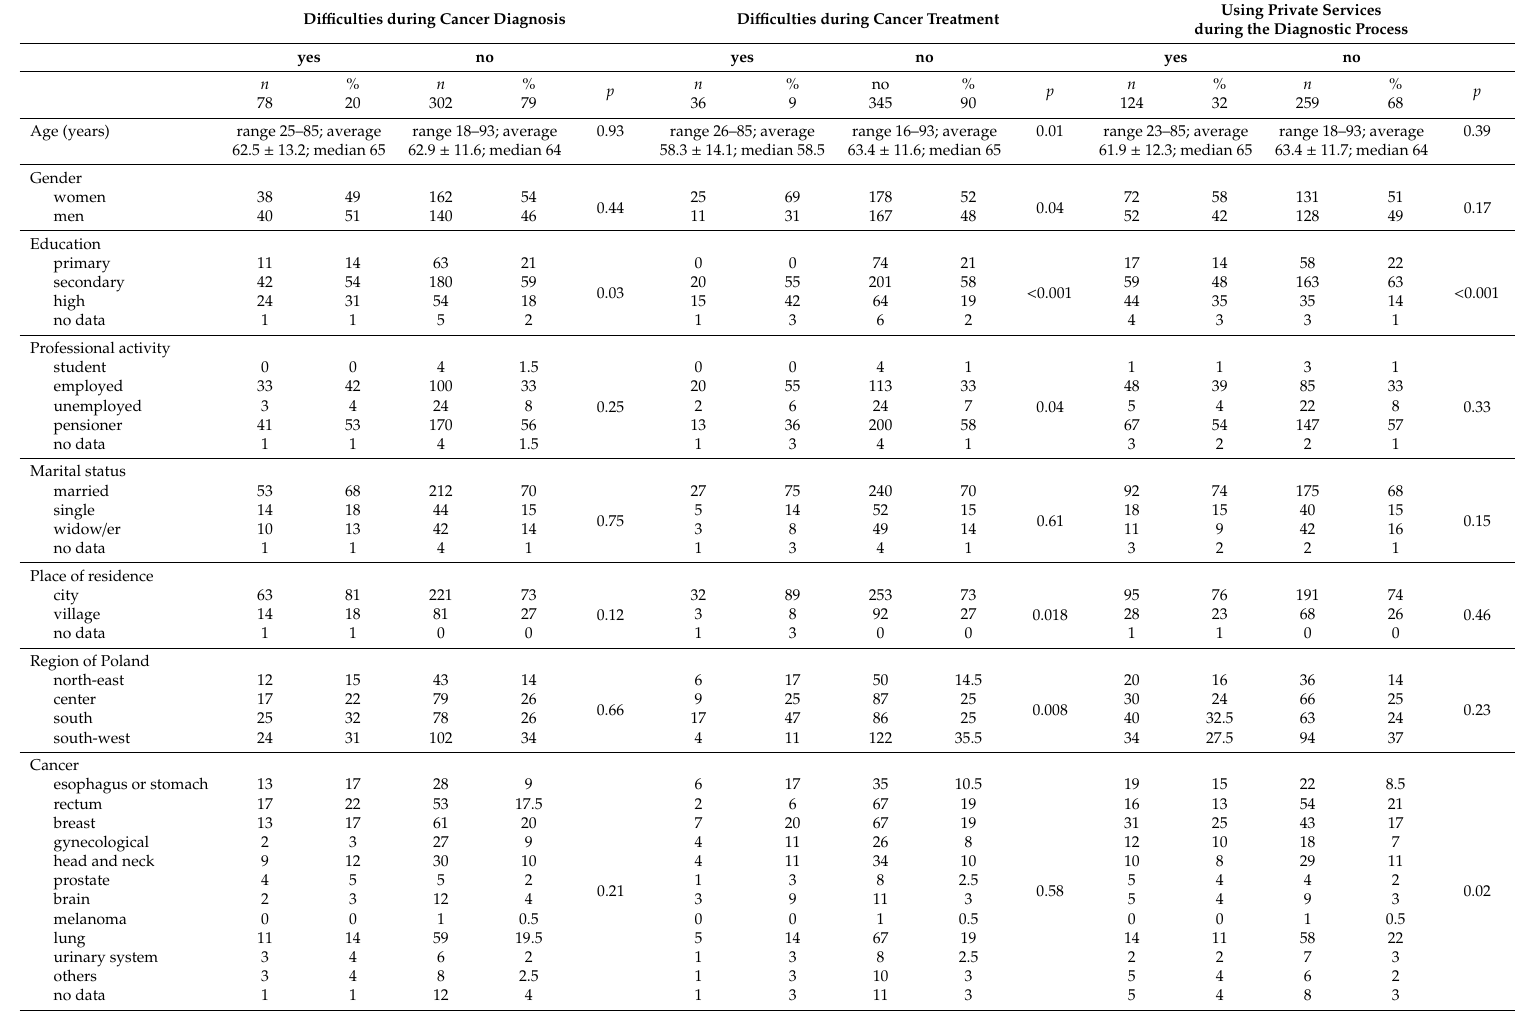
Table 2. Organizational problems of the care